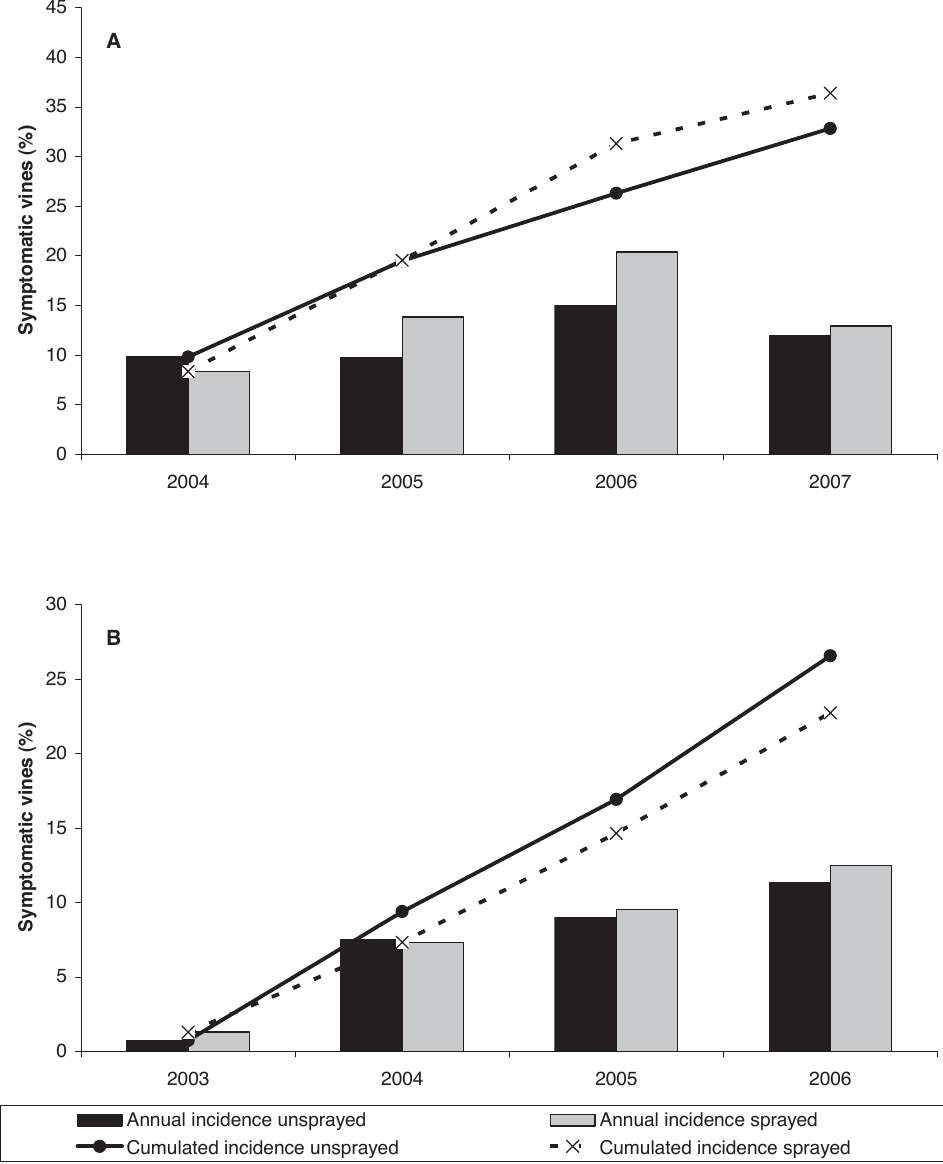
Fig. 1. Effects of applications of Kendal on annual incidence (bars) and cumulated incidence (lines) assessed in vine- yards cv. Albana (A) and Sangiovese (B). For each treatment and year of assessment, values of annual incidence or cumulated incidence are not signi fi cantly different according to Chi–Square test ( P